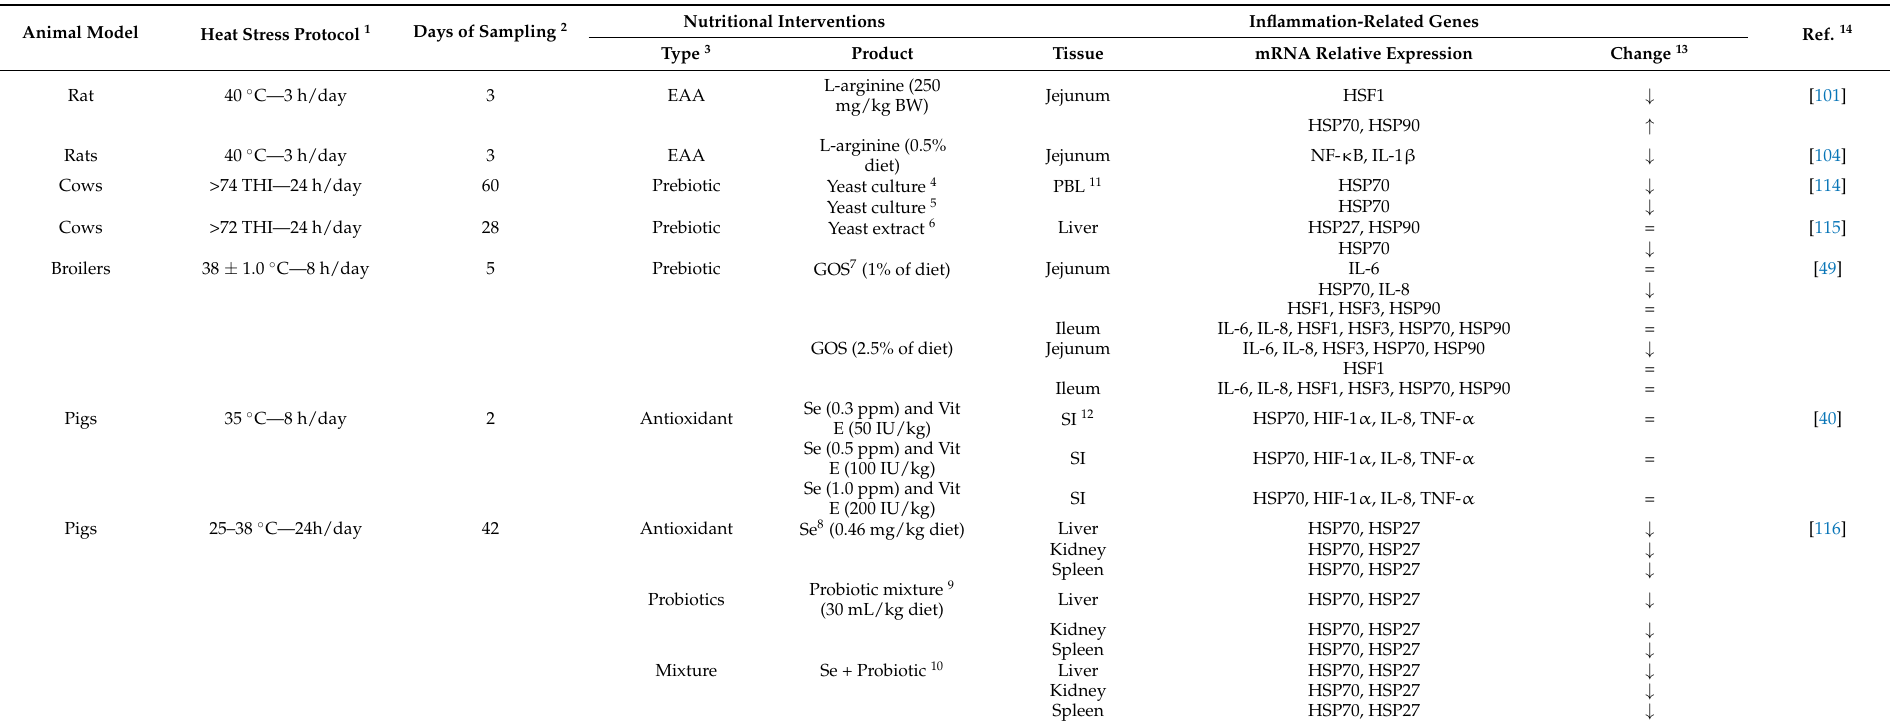
Table 4. Effect of nutritional interventions on the expression of inflammatory-related genes in different tissues during heat